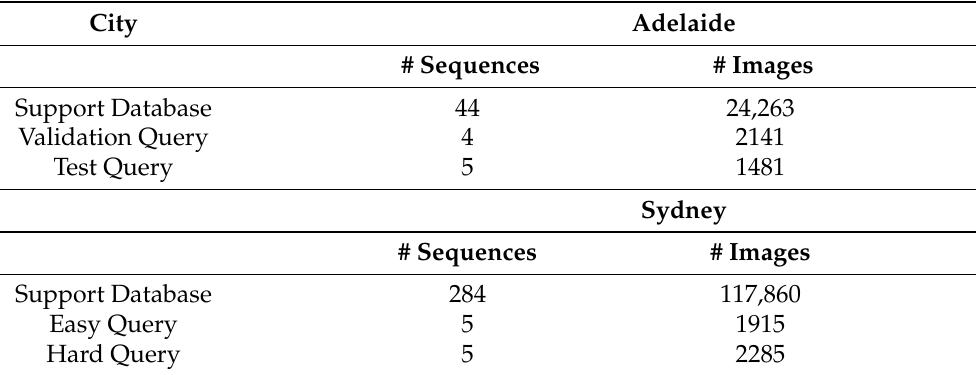
Table 1. Summary of the vision-based localization datasets used in this